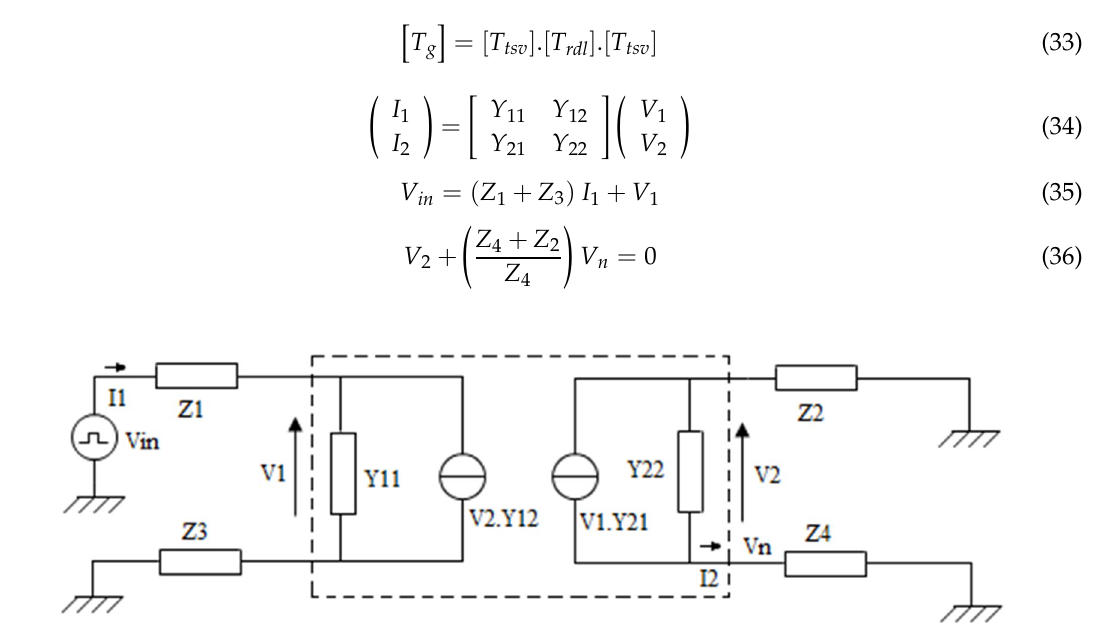
Figure 7. The admittance equivalent circuit of TSV noise coupling with RDLs.